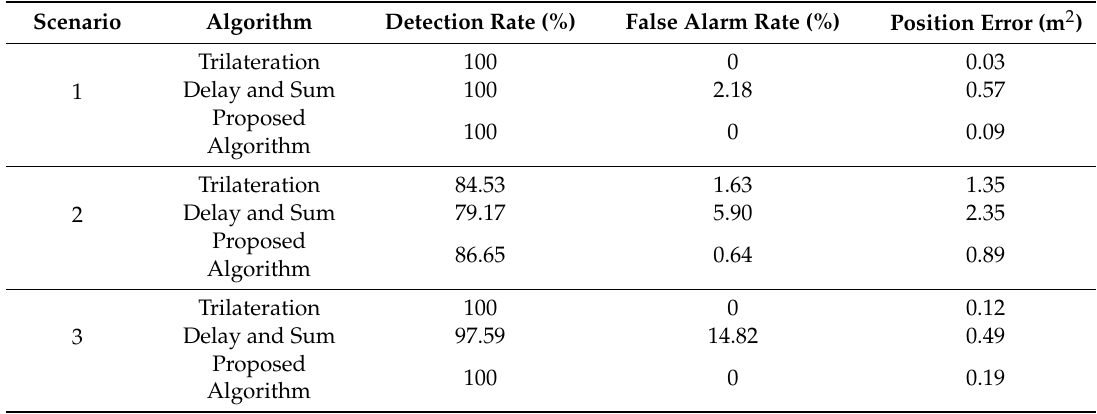
Table 6. Experimental Results for the Three